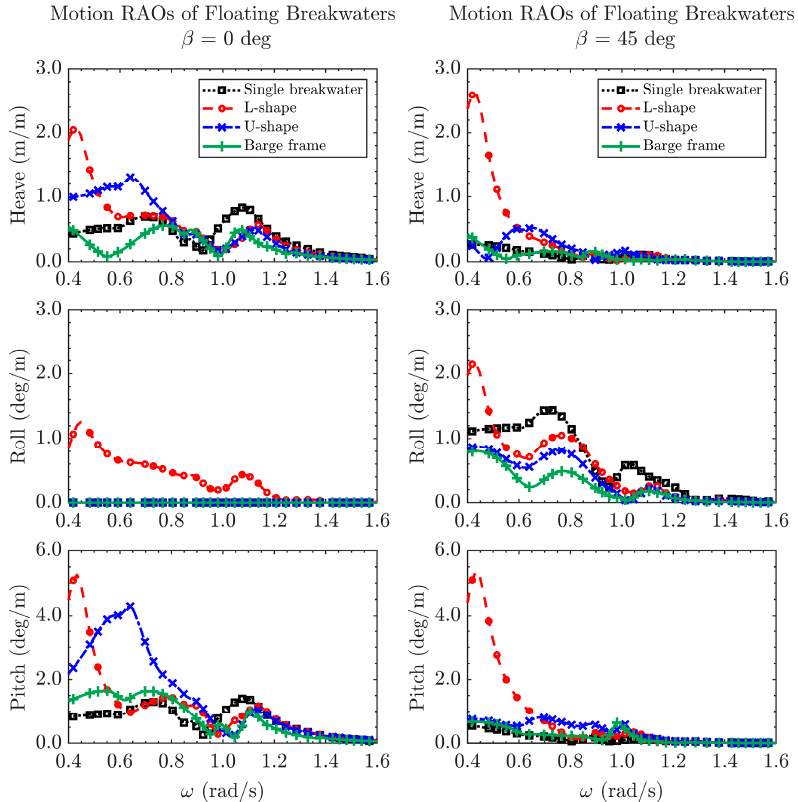
Figure 10. Motion RAOs of the floating breakwaters of different configurations in heave, roll, and pitch with the presence of two floating tanks in 0 and 45 deg incident wave directions.